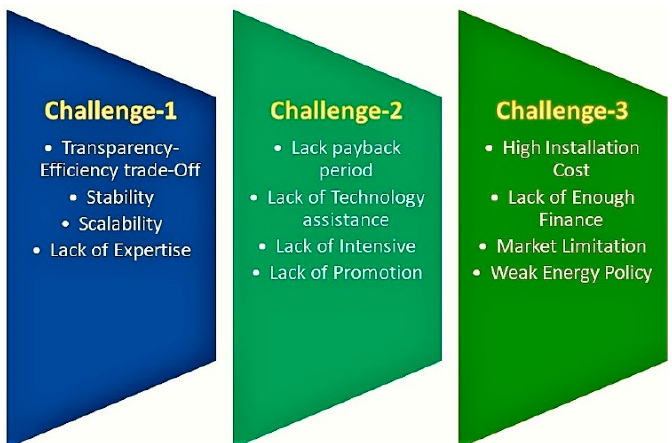
Figure 12. Challenges of a semi-transparent PSC for BIPV application.